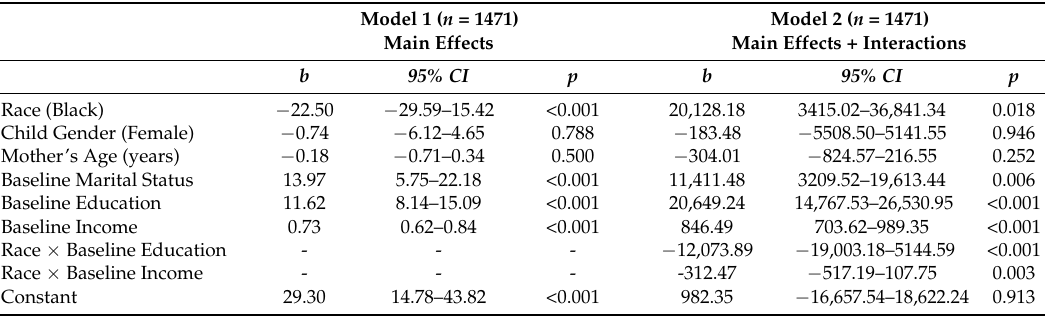
Table 3. Summary of two linear regressions in the pooled